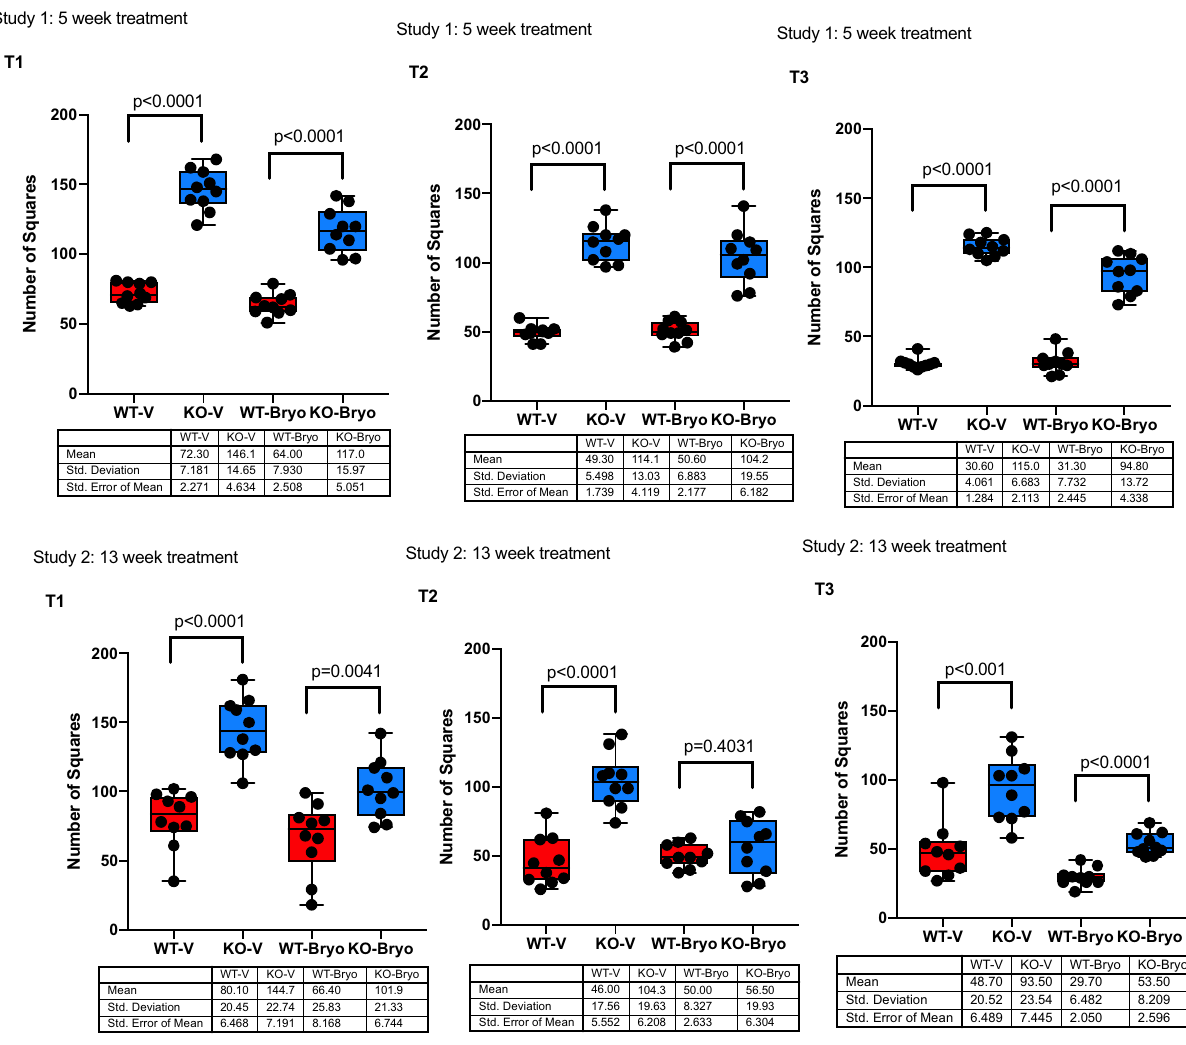
Figure 1. Chronic bryostatin-1 improves the behavioral phenotypes in hyperactivity of the Fmr1 KO2 mice in an open field test. Wild-type (WT) or Fmr1 KO2 (KO) adult mice were treated with vehicle (V) or bryostatin 1 (Bryo) for 5 weeks (Study 1) or 13 weeks (Study 2) and then tested in open field. From T1 to T3, data are shown for hyperarousal (Number of Squares crossed in the open field test) (first time tested in the open field or T1), 10 min after the first open field test (second time exposed to the open field or T2), and 24 h after the first open field test (third time exposed to the open field or T3). We identified a significant improvement in Study 2, T 2 in the open field when compared to WT littermates ( P = 0.4031). Data is visualized as boxplots with interquartile ranges, presenting all the data points. The table indicates the mean standard deviation and the standard error of the mean (N = 10 mice per